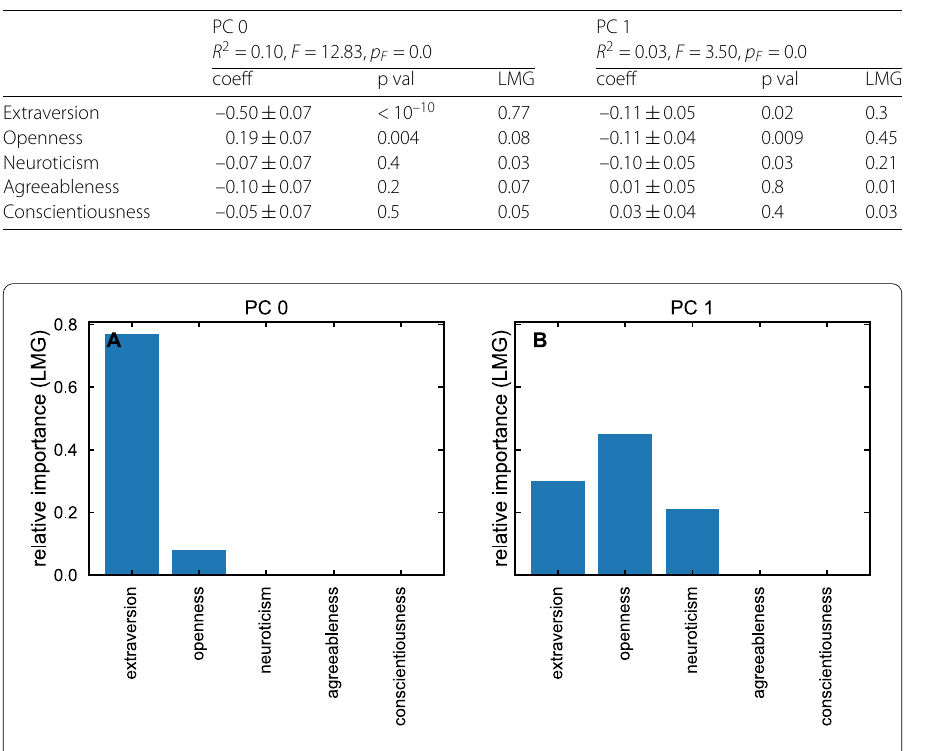
Table 12 Extraversion, openness, and neuroticism explain spatial behaviour. The result of a multiple linear regression explaining principal components of spatial data (see Table 7). The value of each coefficient (coeff) is reported together with the probability (p val) that the coefficient is not relevant for the model. The relative importance of each coefficient (LMG) is computed using the LMG method [79]